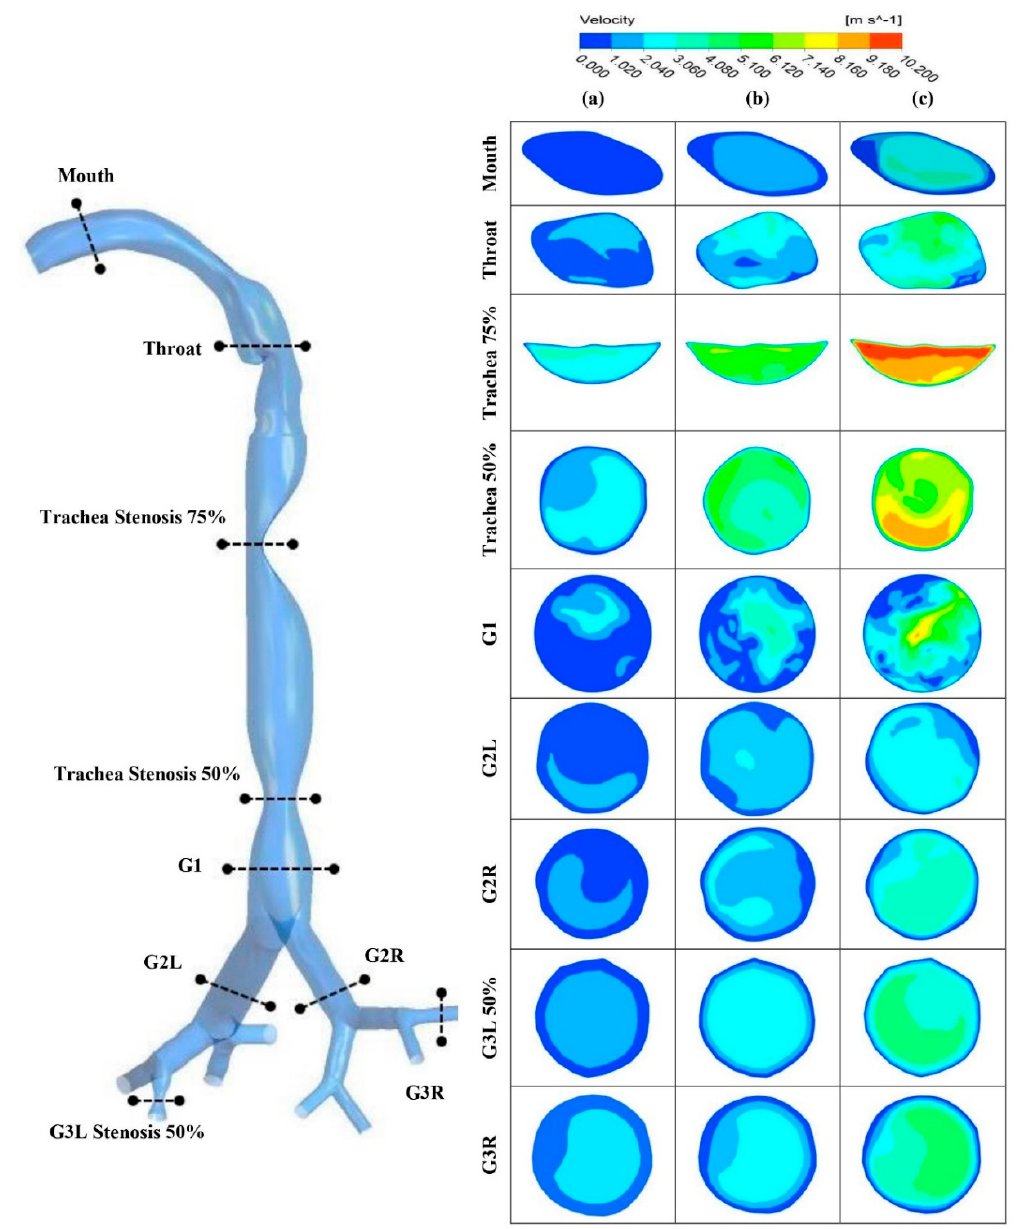
Figure 6. Velocity contours at selected positions of the lung airways: ( a ) 7.5 L/min; ( b ) 15 L/min; and ( c ) 25 L/min. Trachea 75%, Trachea with stenosis 75%; Trachea 50%, Trachea with stenosis 50%; G1, Generation 1; G2L, Generation-2 at left lung; G2R, Generation-2 at right lung; G3L 50%, Generation-3 at left lung with stenosis 50%; and G3R, Generation-3 at right lung.